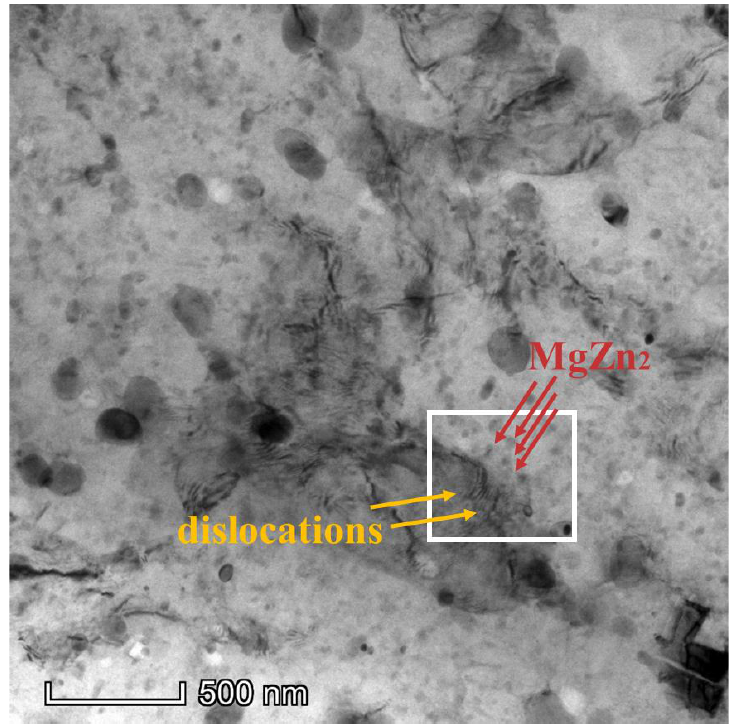
Figure 7. Bright-field TEM images for the interaction between nano-MgZn 2 phases and dislocations.